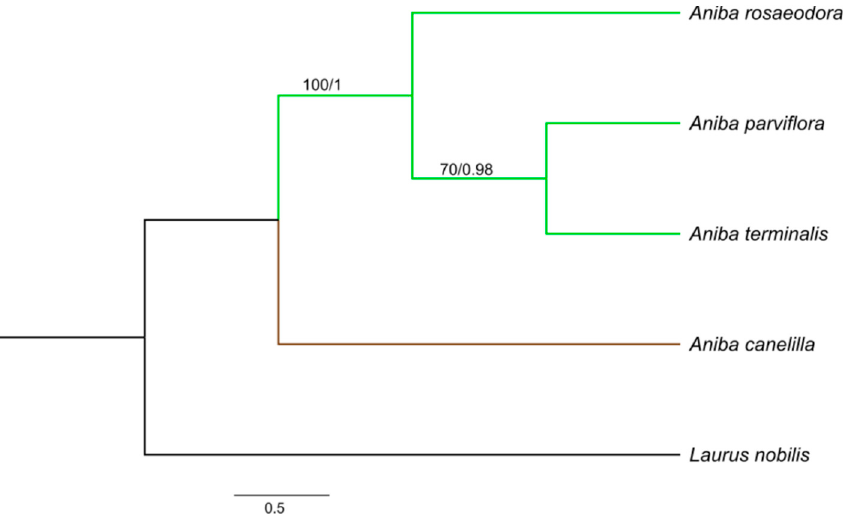
Figure 3. Bayesian consensus tree based on rbcL + matK + trnH – psbA + internal transcribed spacer (ITS) sequences of species of Aniba and Laurus nobilis (outgroup). Bootstrap support values ( ≥ 70%)/Bayesian posterior probabilities (>0.9) are shown above the branches.